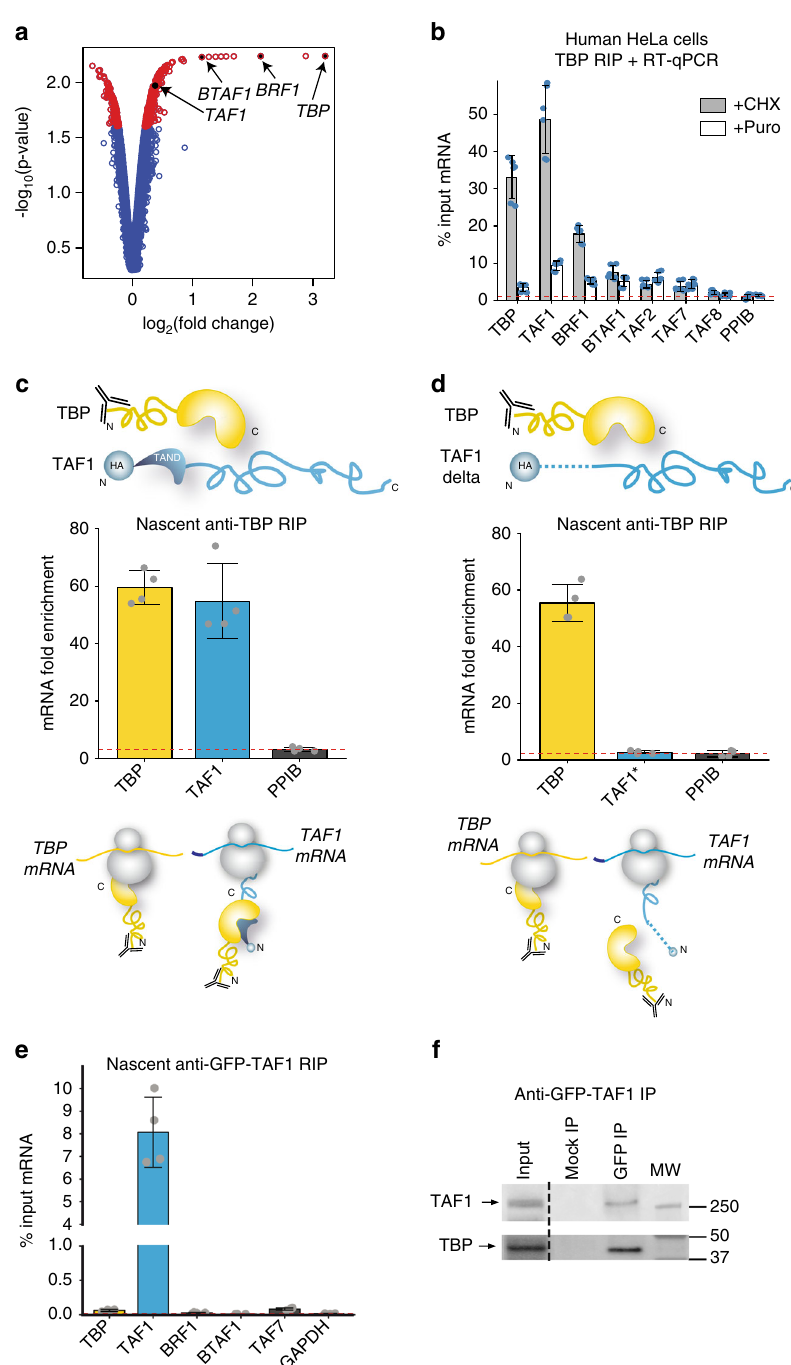
Fig. 7 Co-translational assembly of TBP and TAF1. a Microarray results of RIP with an antibody targeting the N-terminus of the endogenous TBP protein. Volcano plot depicting microarray results as log2 of the fold change of IP over mock. A p -value cut-off ≤ 0.025 was applied and corresponding transcripts are in red. Transcripts of interest are highlighted in black. b RIP-qPCR validation of microarray results in HeLa polysome extracts. c , d RIP-qPCR using anti- TBP antibody in HeLa cells transfected with TBP and HA-TAF1 expression constructs ( c ) or with TBP and HA-TAF1 with N-terminal deletion of the fi rst 168 amino acids ( d ). e Anti-GFP RIP-qPCR from polysomes of HeLa cells stably expressing GFP-TAF1. f Western blot analysis (WB) of GFP IP from polysome extracts prepared from GFP-TAF1 cell line. In ( f ) the dotted line indicates the cutting out of unnecessary lanes. All error bars are ±SD from three ( b ) or two ( c – e ) biological replicates and two technical replicates [represented by blue dots in ( b ) or grey dots ( c – e )]. Molecular weight (MW) markers are shown in kDa. PPIB ( b – d ) and GAPDH ( e ) were used as unrelated control mRNAs. Source data provided as a Source Data